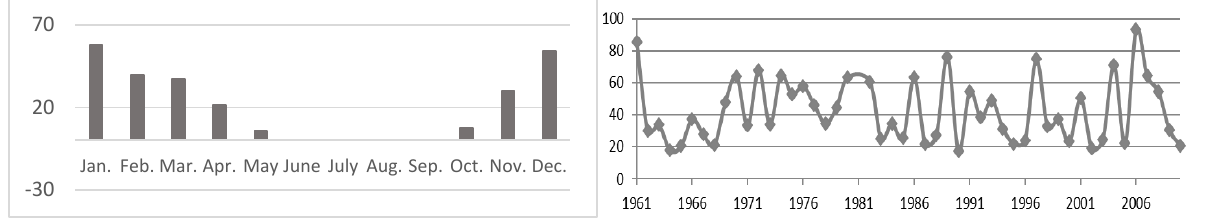
Chart 1. Average monthly rainfall during